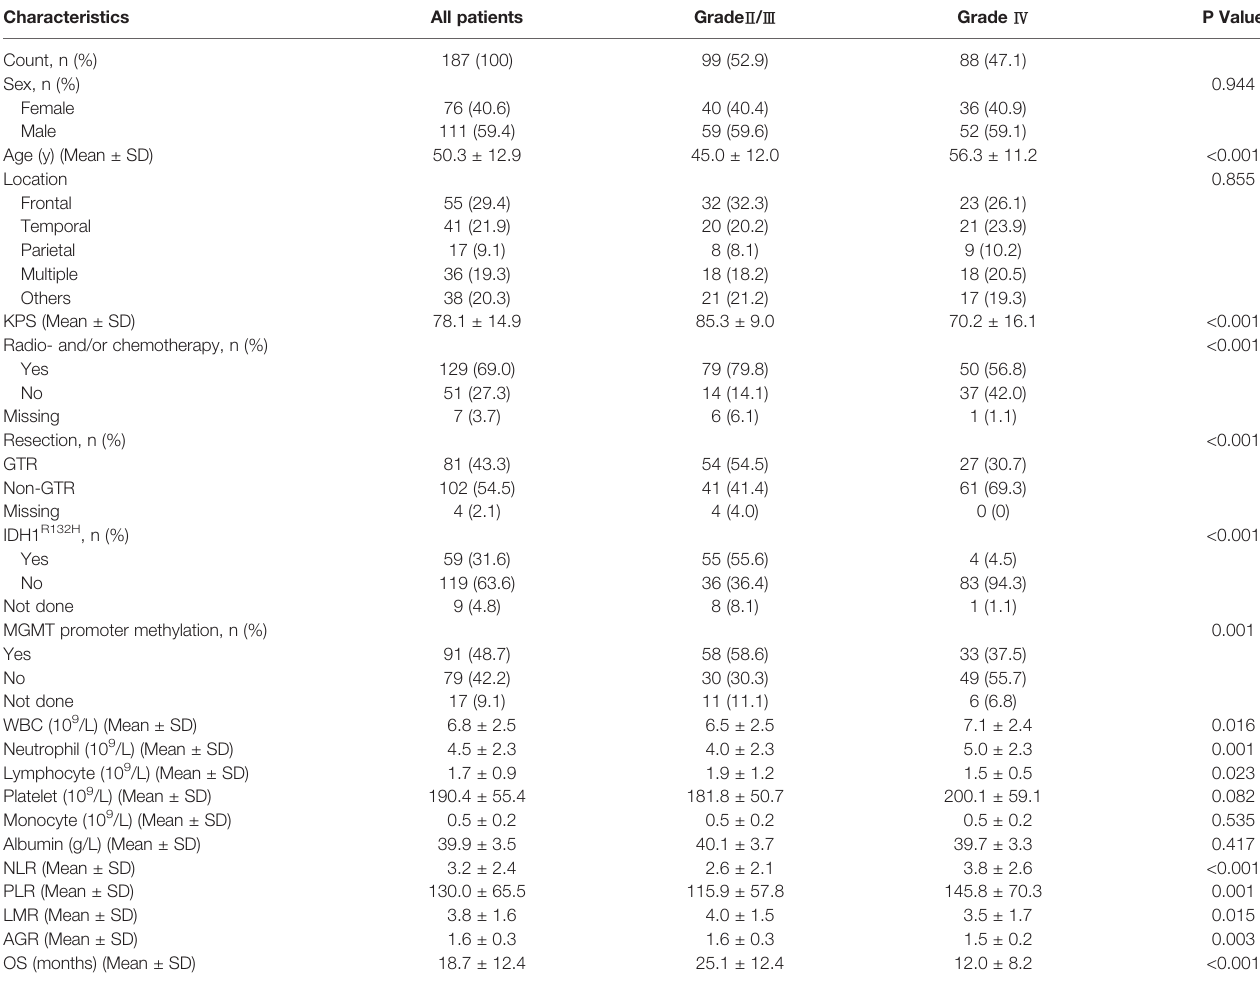
TABLE 1 | Clinical and pathological characteristics of patients. Characteristics All